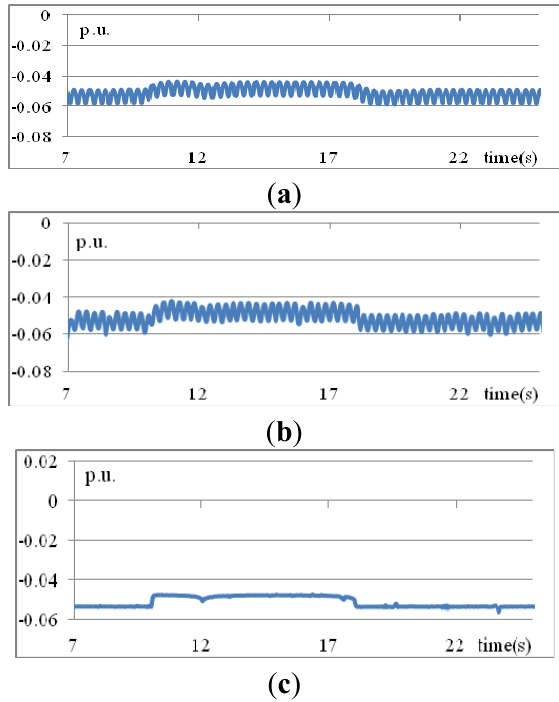
Figure 14. MVARs from STATCOM obtained using three methods: ( a ) traditional PID; ( b ) T1 fuzzy rules; ( c ) IT2 fuzzy rules (Scenario